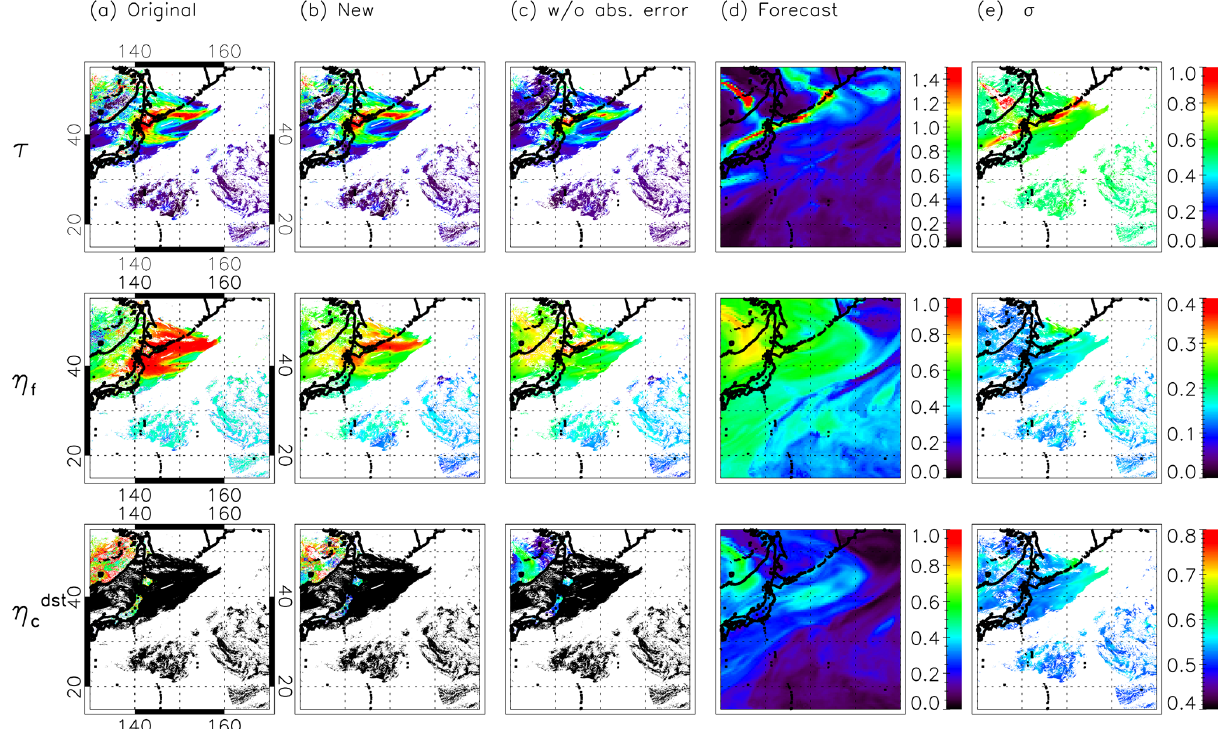
Figure 12. Same as Fig. 4, except for using the forecast on 27 April 2018 as an a priori estimate.